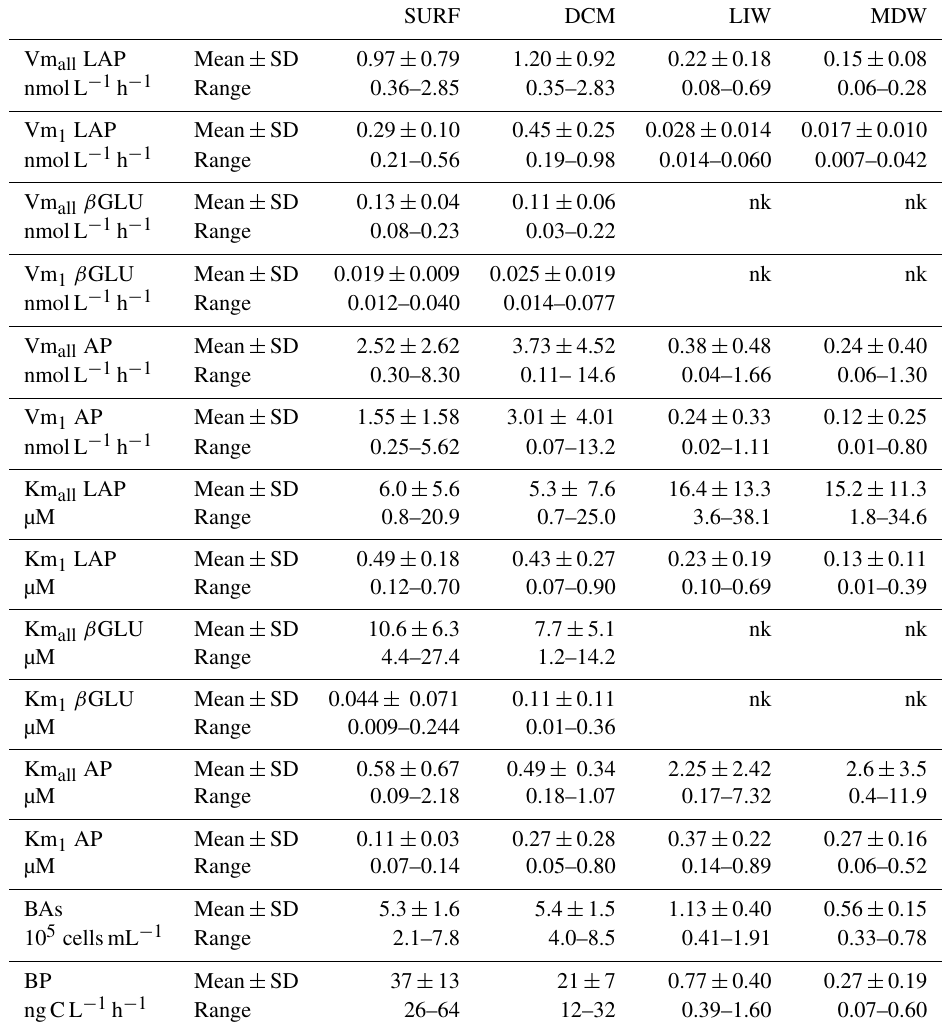
Table 2. Heterotrophic bacterial abundances (BAs), bacterial production (BP) and ectoenzyme kinetic parameters of the global model (Vm all , Km all ) obtained from the entire substrate range (0.025 to 50µM) and of model 1 (Vm 1 , Km 1 ) obtained from the low substrate range (0.025 to 1µM) for leucine aminopeptidase (LAP), β -glucosidase ( β GLU) and alkaline phosphatase (AP) at the four layers. Mean ± SD and range values given for all stations. Maximum velocity rates (Vm all and Vm 1 ), half-saturation constants (Km all and Km 1 ); nk: no kinetics available as there are not enough significant rates to plot Michaelis–Menten